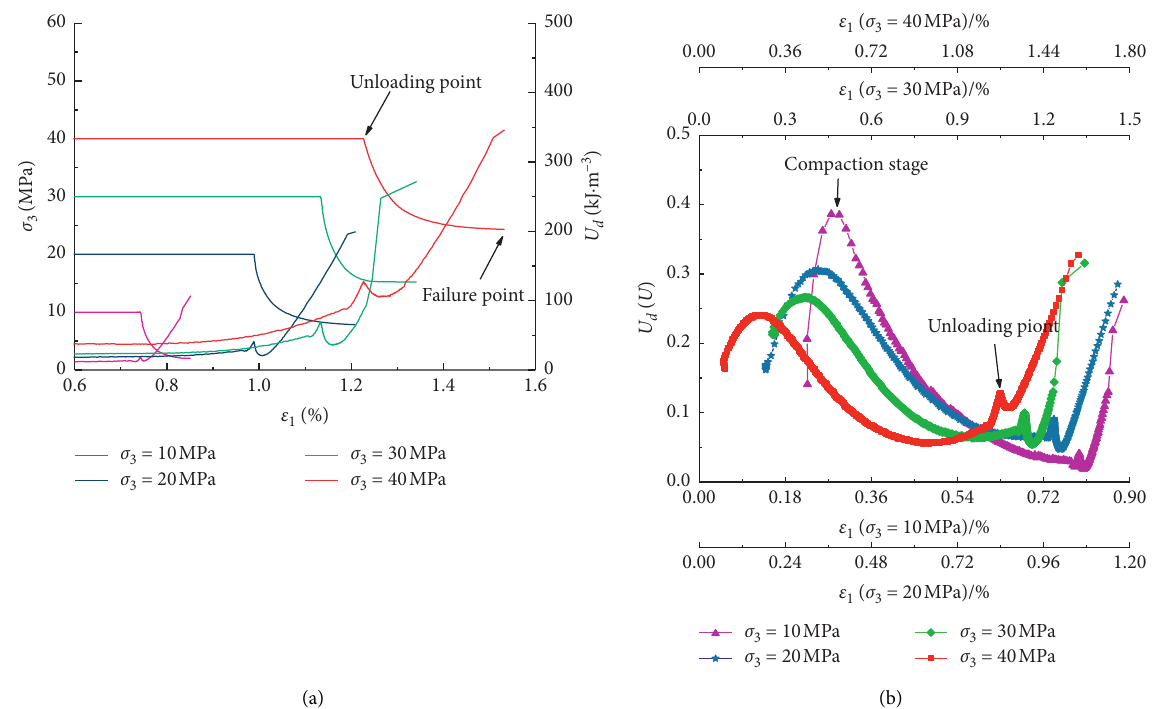
Figure 11: Typical curves of dissipation energy variation of sandstone unloading failure under different initial confining pressures. (a) Relationship between confining pressure and dissipative energy. (b) Evolution characteristics of (U)d/(U) under different initial confining